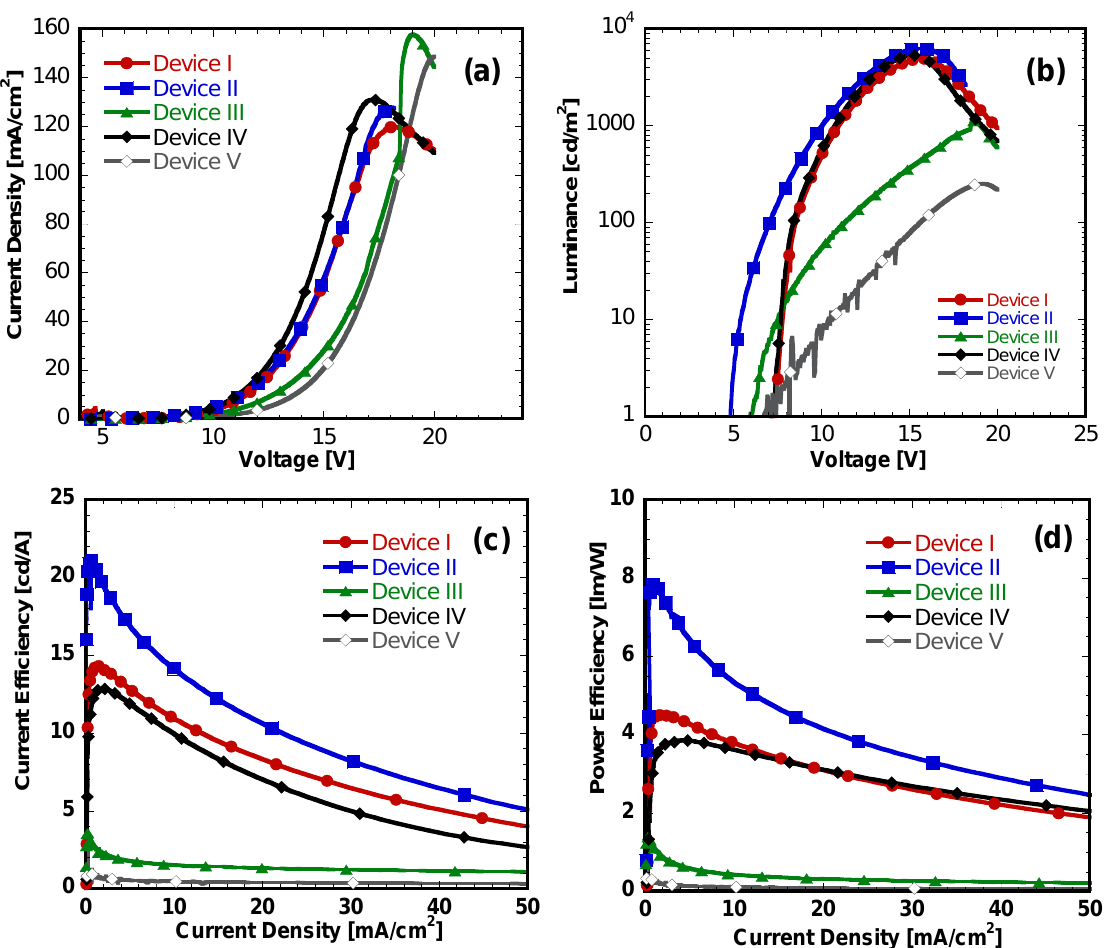
Figure 4. Device characteristics of the solution-processed blue PHOLEDs. ( a ) Current density-voltage ( J-V ); ( b ) luminance- voltage ( L-V ); ( c ) current efficiency-current density ( CE-J ); and ( d ) power efficiency-current density ( PE-J ) curves.